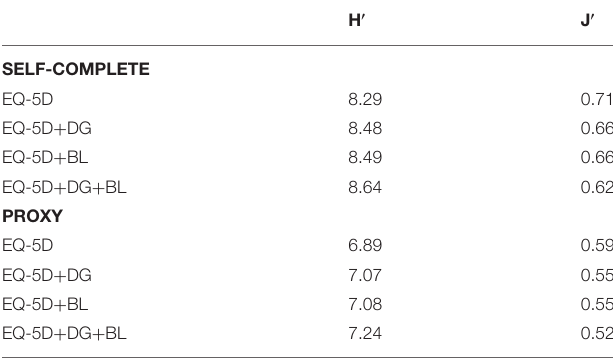
TABLE 6 | Shannon index (H ′ ) and Shannon Evenness index (J ′ ) of EQ-5D and bolt-on items.